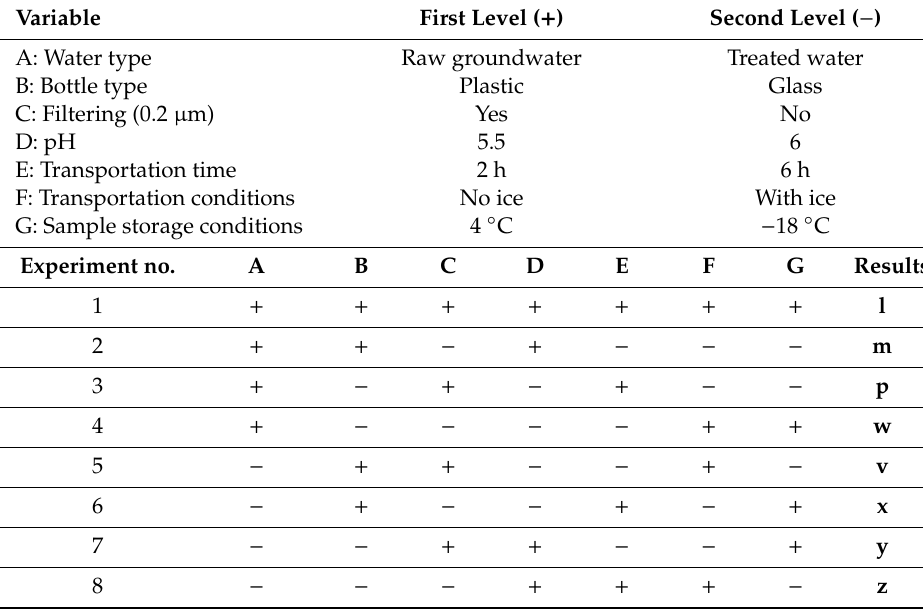
Table 3. Tested factors at two levels used in Plackett–Burman